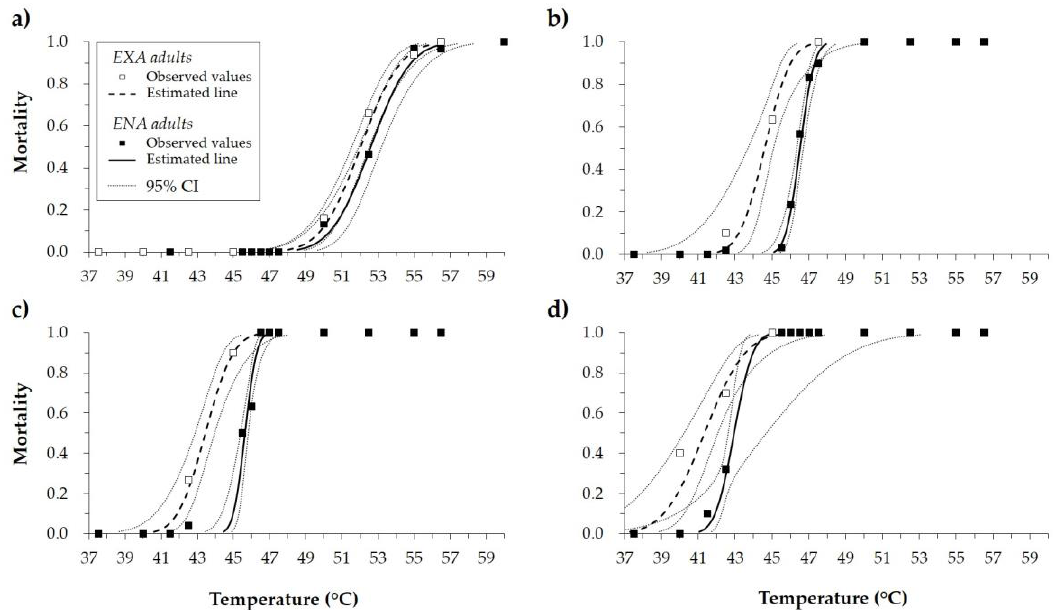
Figure 1. Mortality rate (observed values, estimates of the curves, and 95% confidence interval (CI)) of Halyomorpha halys adults (exiting diapause (EXA) and entering diapause (ENA)) after exposure to high temperatures for ( a ) 2.5, ( b ) 15, ( c ) 30, and ( d ) 60 minutes.